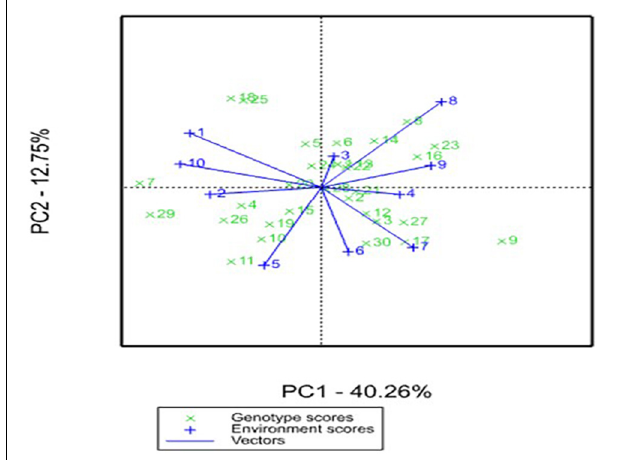
FIGURE 1 | Additive Main Effects and Multiplicative Interaction (AMMI) biplot for grain yield across environments in West and Central Africa. 1. AFRIBEH-NAARA, 2. AKAD-KOM, 3. CHAKTI, 4. Faringuero, 5. Gamoji, 6. GB 8735, 7. IBMV 8402, 8. ICMP 177001, 9. ICMP 177002, 10.